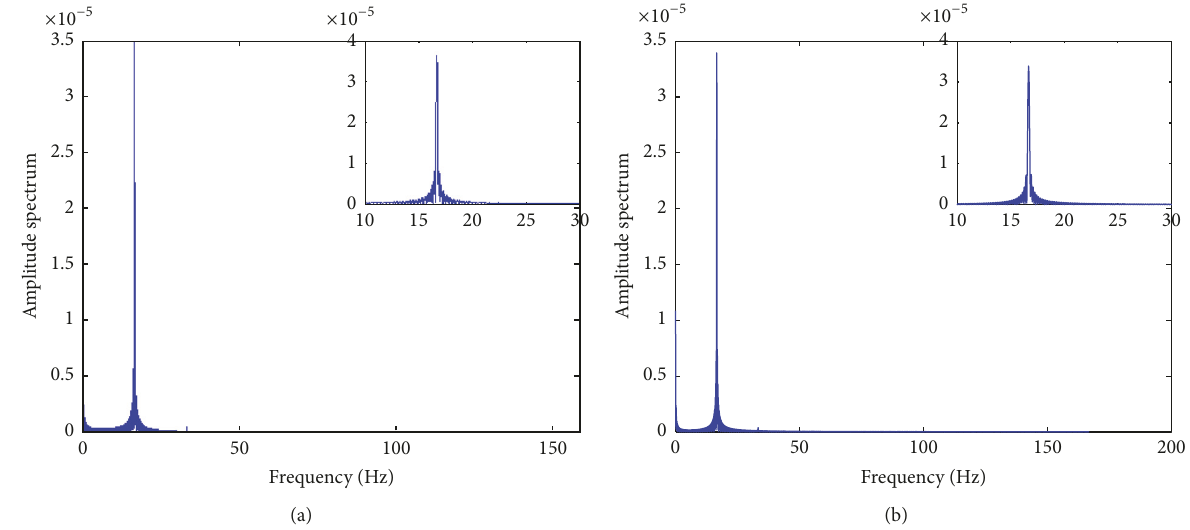
Figure 9: FFT of tip deflection in steady state regime, in vertical (a) and lateral (b) directions for the total model.